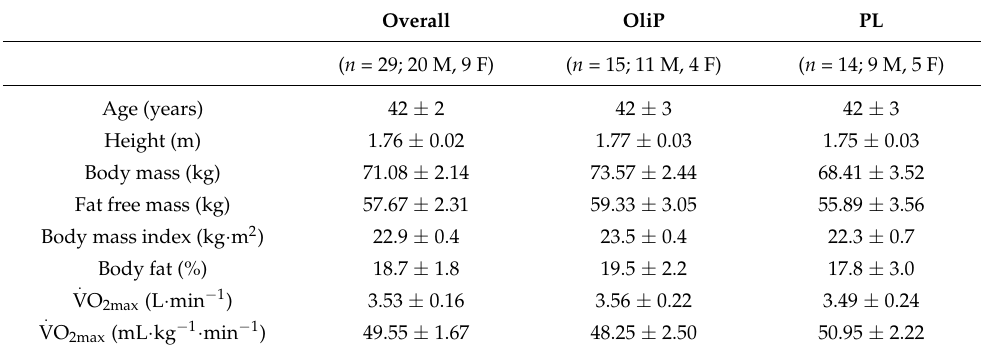
Data presented as mean ± S.E. M = male; F = female. No significant differences reported between